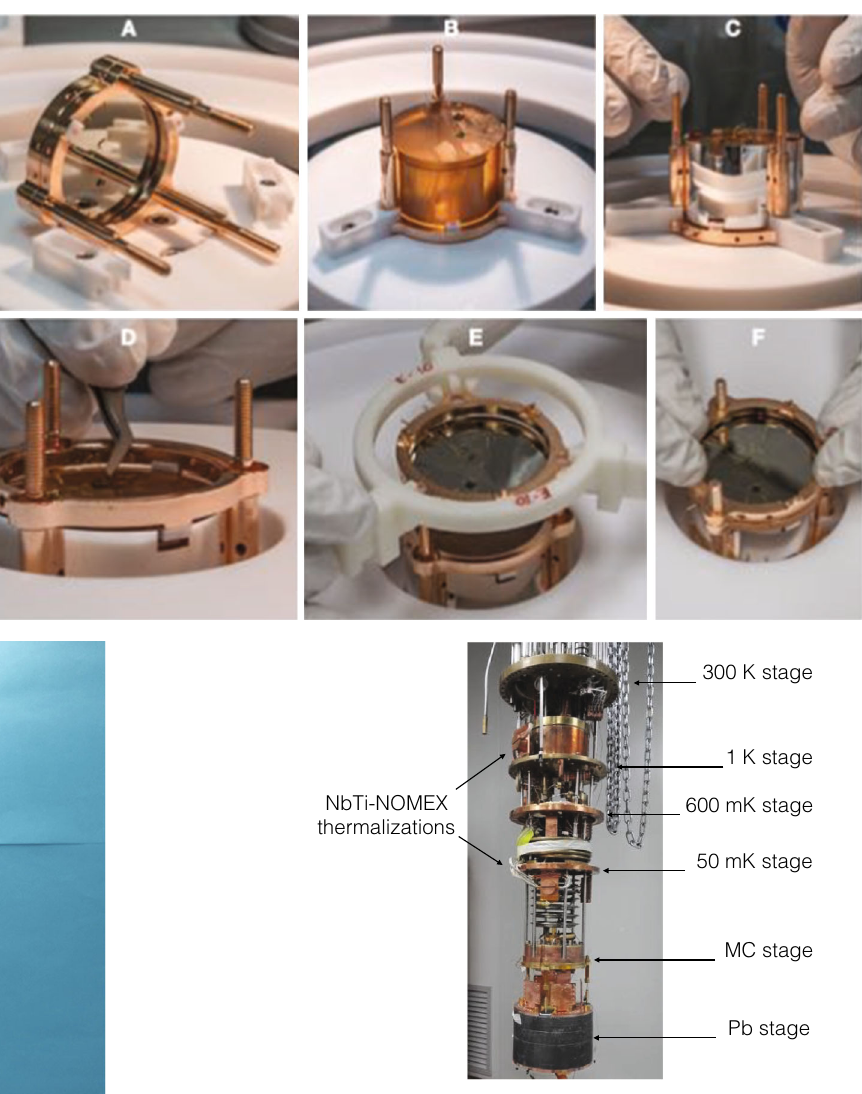
Fig. 15 Dilution unit photo. The different thermalization stages are identifiedbythearrows.ARomanPbshieldishungontheMCstagesby means of a vibrational damping system. The junction board is installed on the Pb stage, this is shown in Fig.